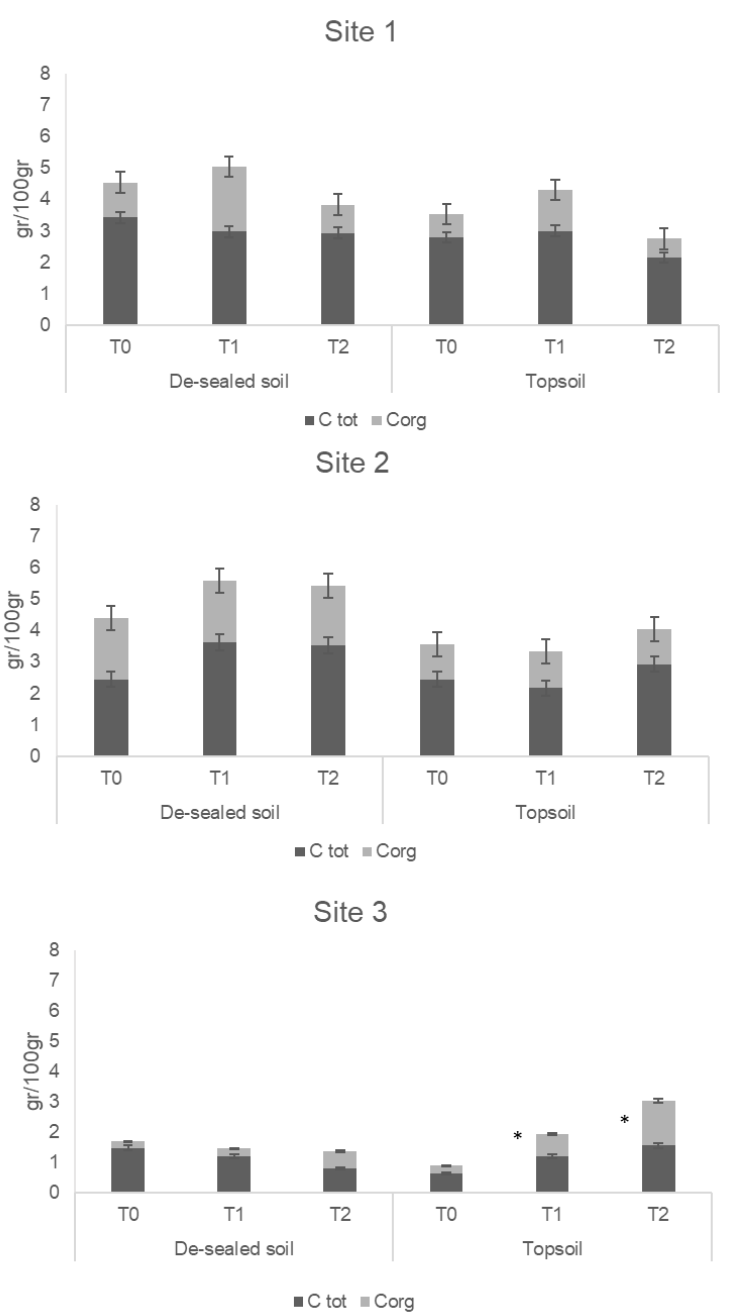
Figure 3. Total concentration of total carbon (C tot) and organic carbon (C org) for Site 1, Site 2 and Site 3, respectively, during the three sampling points (T0, T1 and T2). Values are the average ( n = 3) ± standard error of the means. Asterisk identifies statistical differences among topsoil and de-sealed soil within the same time identified by Tukey’s test at p < 0.05.